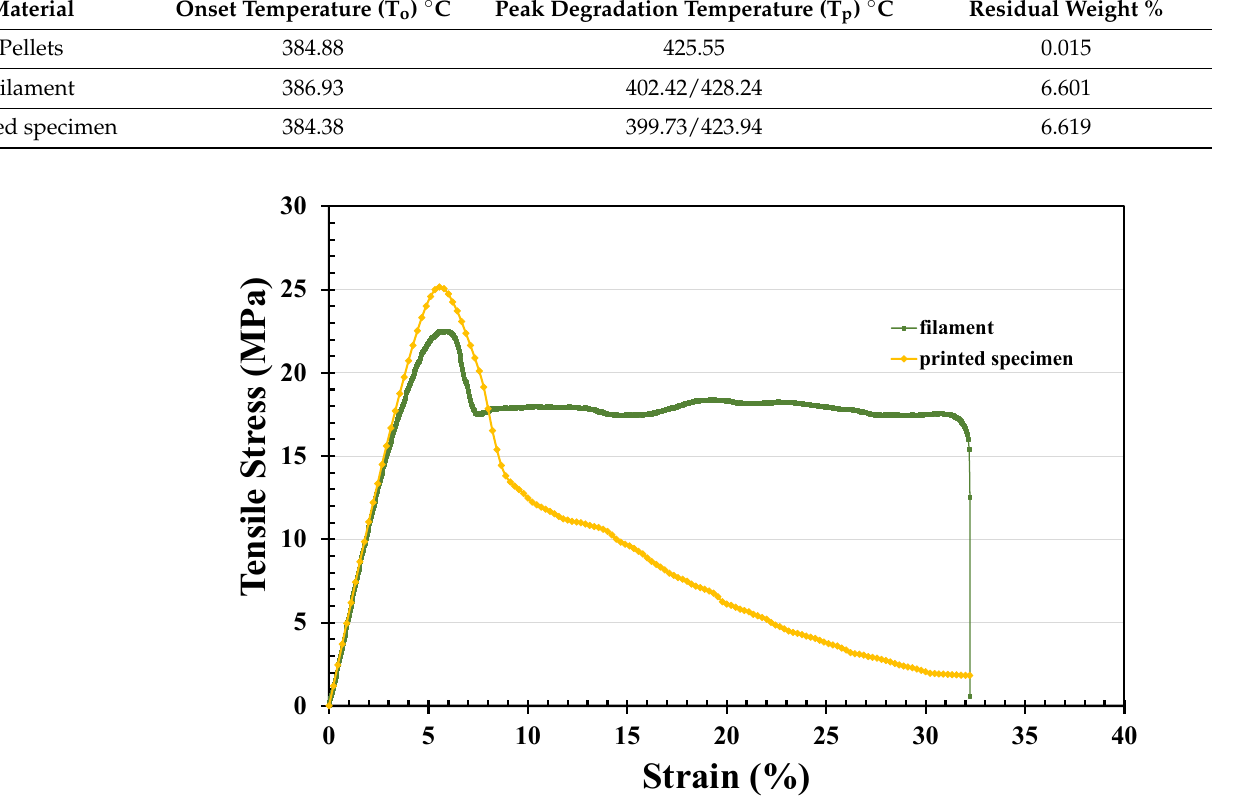
Figure 7. Stress–strain curves of the extruded filament (diameter, 1.72 mm; measured length, 37.5 mm; tension rate, 5 mm/min) and the printed specimen (ASTM D638; section, 3.16 × 2.7 mm; measured length, 15 mm; tension rate, 5 mm/min).